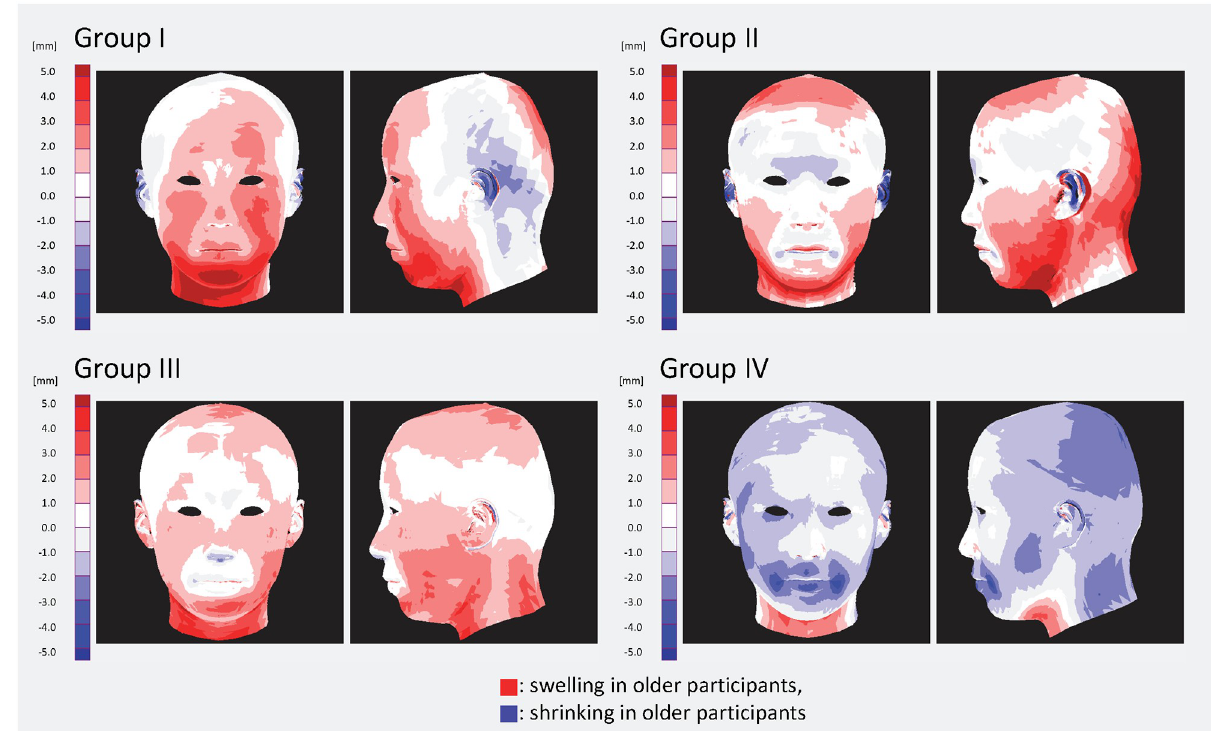
Fig 6. Differences in facial forms between younger and older a participants in each group. a Participants under and over the mean age of each group.